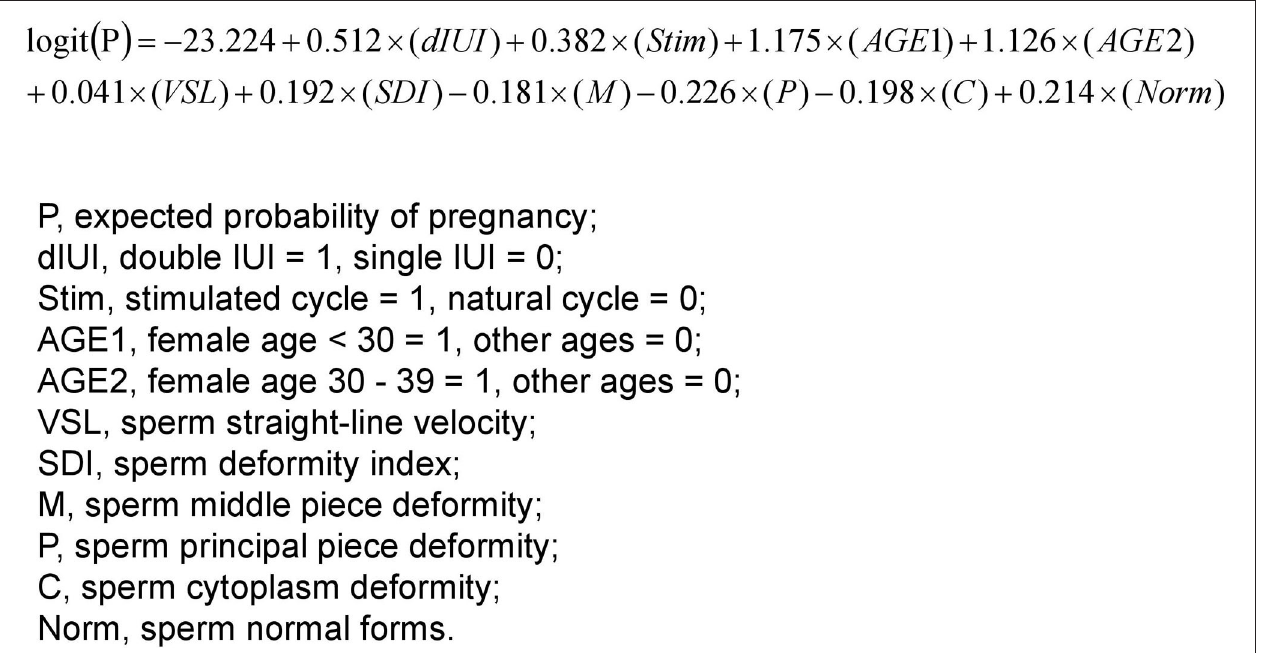
FIGURE 1 | A multivariate logistic regression equation for predicting successful pregnancy following AIH. The 10 parameters were selected and weighted for predicting the probability of pregnancy via the multivariate binary logistic regression analysis performed by backward stepwise elimination. Thus, for each AIH case, the 10 parameters can be put into the equation to calculate the expected probability of pregnancy, which holds the potential to serve as a predictor for the outcome of the AIH treatment.